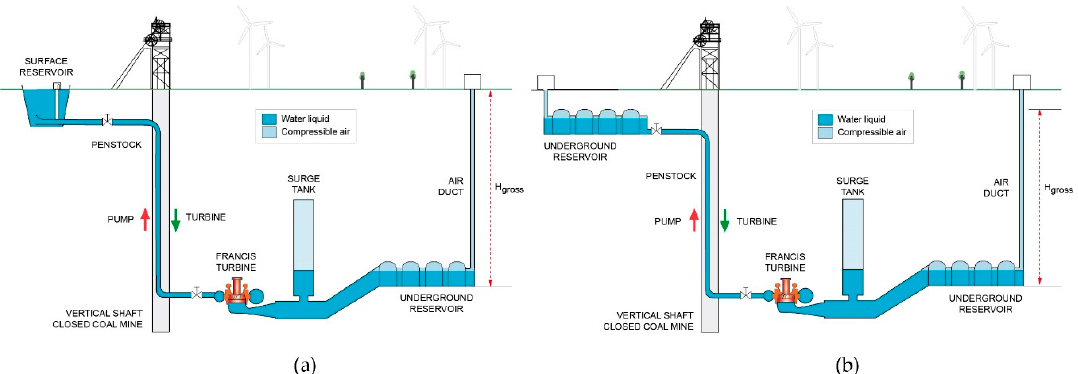
Figure 2. UPSH scheme in a closed mine. ( a ) Surface upper reservoir and underground lower reservoir; ( b ) Shallow upper reservoir and underground lower reservoir.